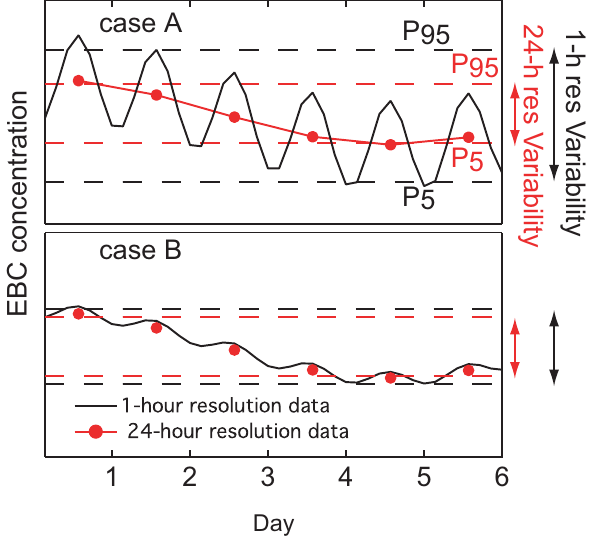
Fig. 7. Agreement of model BC and experimental EBC concentrations determined by overlap of probability density curves at Alert (blue triangle), Bondville (green pen circles), Ispra (yellow open squares), Jungfraujoch (light blue circles), Mace Head (red squares), and Trinidad Head (black triangles). Trinidad Head agreement is calculated with σ ∗ equal to 10 m 2 g − 1 (black triangles) and 20 m 2 g − 1 (gray diamonds).